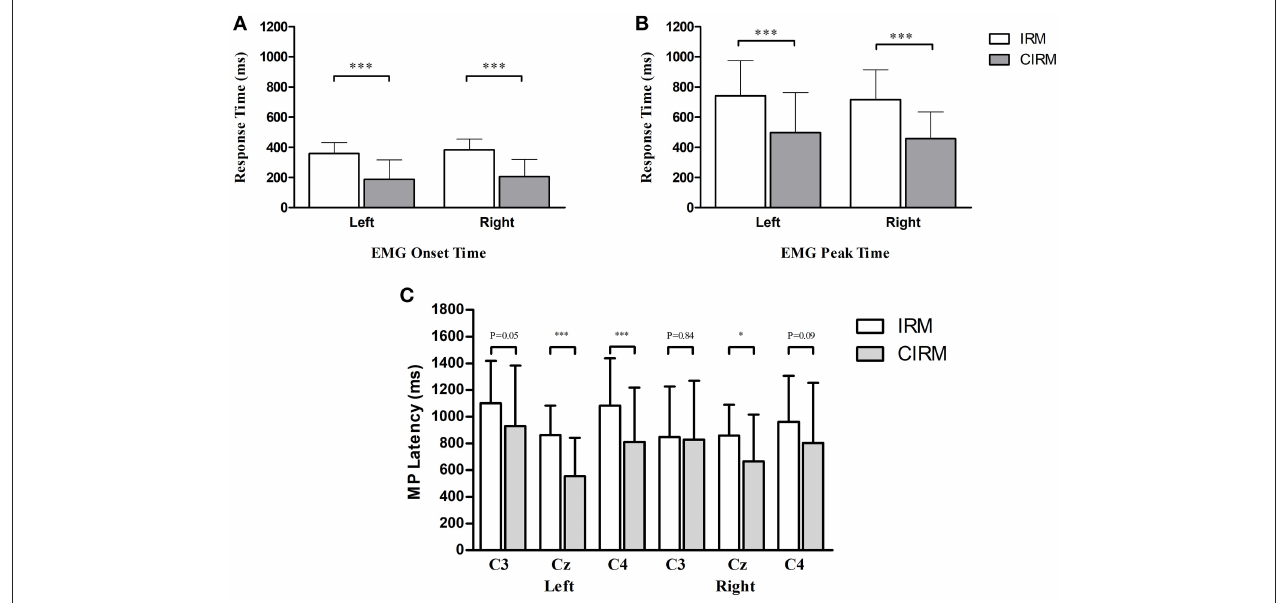
FIGURE 2 | Bar graphs showing averaged EMG onset time (A) , EMG peak time (B) , and MP latency (C) in IRM and CIRM. Error bars represent the SD. Significant differences are indicated by asterisks. (A) The average EMG onset time is shorter in CIRM than in IRM. (B) The average EMG peak time is shorter in CIRM than in IRM.